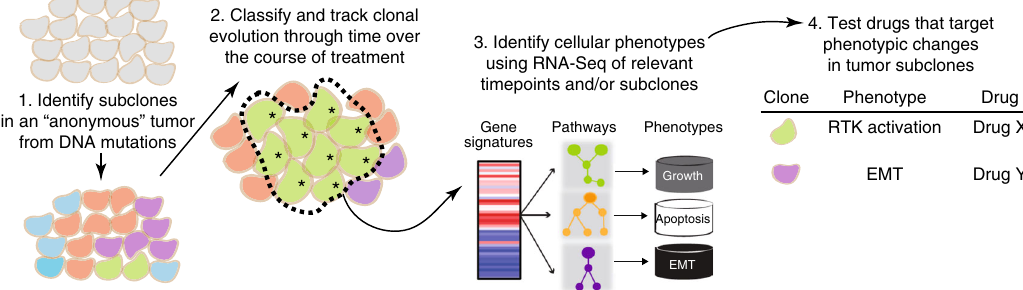
Fig. 1 Overview of systems approach for identifying therapeutic vulnerabilities from longitudinal genomic analysis. *resistant